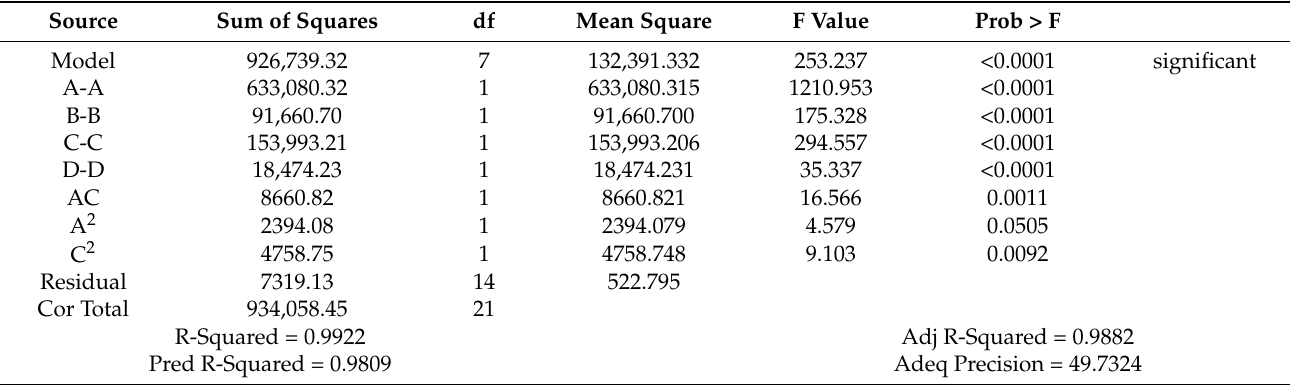
Table A6. ANOVA analysis for the regression model of strip